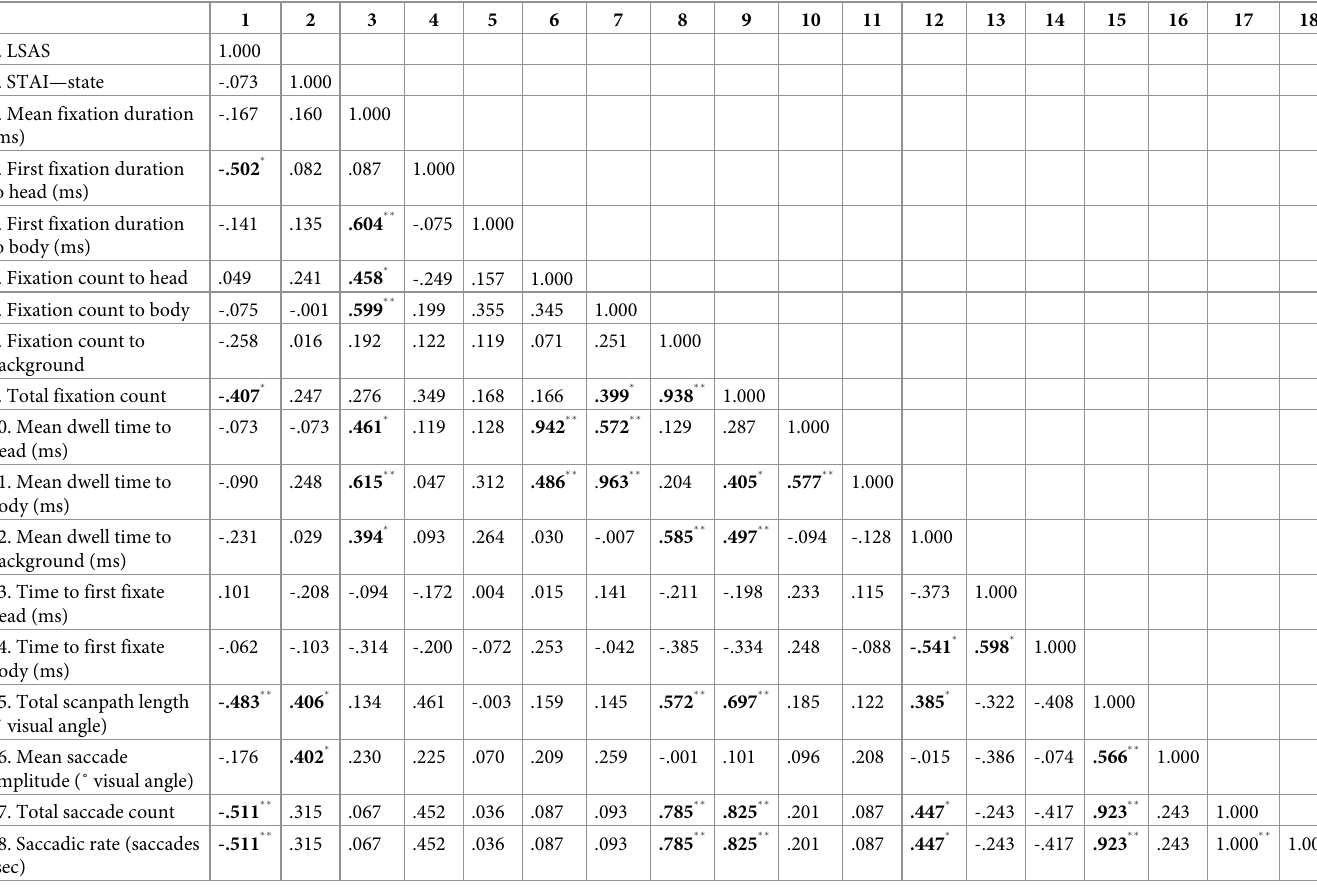
Table 2. Pearson correlation matrix for all eye movement and self-report measures.